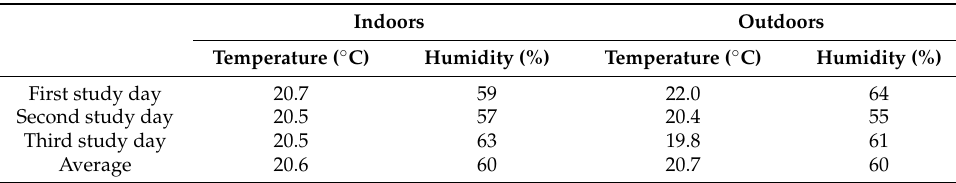
Table 2. The temperature and humidity of the study days.